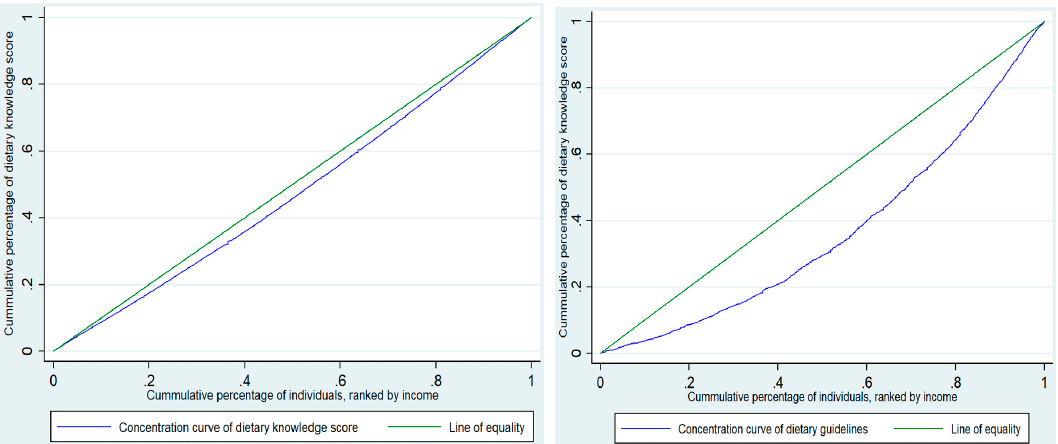
Figure 2. Concentration curves of the dietary knowledge score and dietary guideline awareness, respectively. The green line, running from the lower left corner to the upper right corner, represents the line of equality. The blue line above the equality line is the concentration curve. The farther the concentration curve is below the equality line, the more the health sector variable concentrates among the rich.